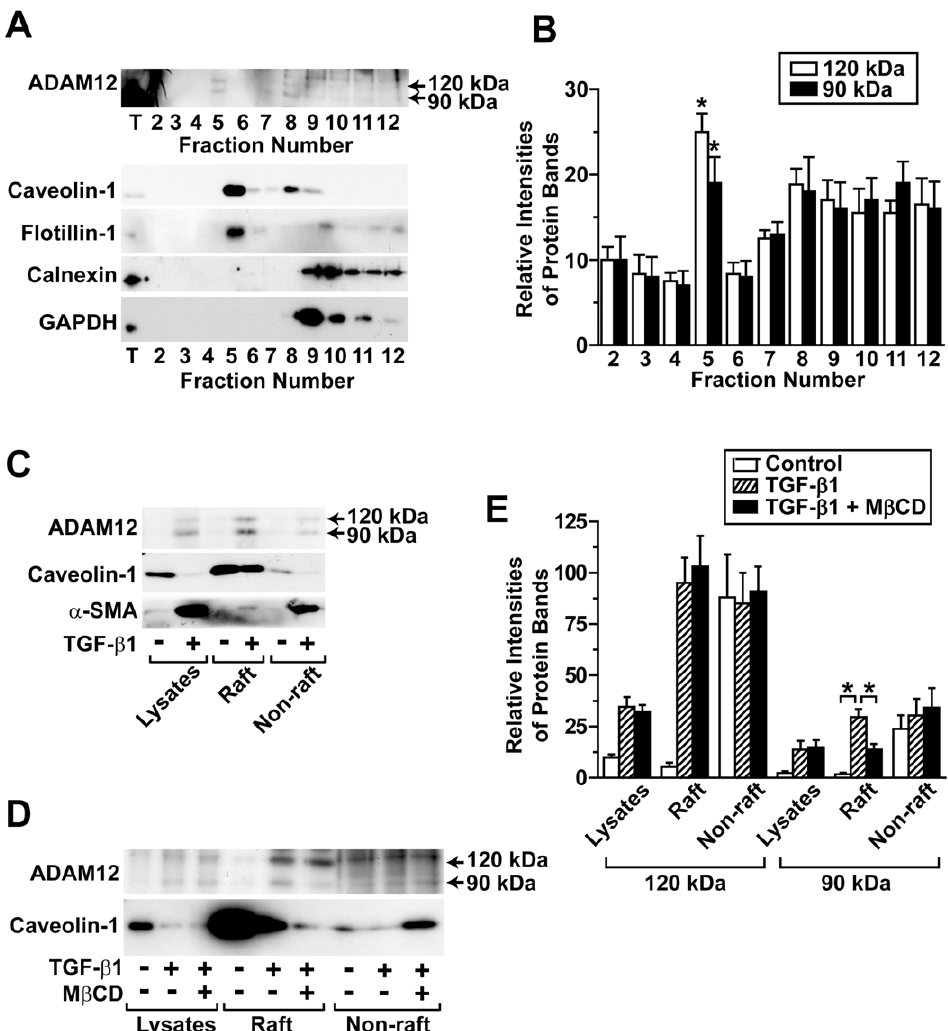
Figure 3. TGF- b 1-stimulated expression of ADAM12 in lipid raft fractions of hASCs. (A) Existence of ADAM12 in lipid raft fractions. hASCs were treated with 1 ng/mL TGF- b 1 for 4 days and lipid rafts were fractionated by sucrose density gradient centrifugation. The protein levels of ADAM12, caveolin-1, flotillin-1, calnexin, and GAPDH in each fraction were probed by Western blot analysis. (B) The relative intensities of ADAM12 protein bands with molecular masses of , 120 kDa and , 90 kDa from the panel (A) were quantified. * p , 0.05 vs fraction number 2. (C) TGF- b 1- stimulated expression of ADAM12 in lipid raft fractions. hASCs were treated with serum-free medium in the presence or absence of 1 ng/mL TGF- b 1 for 4 days, and then lipid rafts were fractionated. (D) Effects of cholesterol depletion on TGF- b 1-stimulated expression of ADAM12 proteins in lipid raft fractions. hASCs were treated with serum-free medium in the presence or absence of 1 ng/mL TGF- b 1 for 4 days. TGF- b 1-treated hASCs were subsequently treated with 5 mM M b CD or vehicles for 30 min. The expression levels of ADAM12, caveolin-1, and a -SMA in cell lysates, the lipid raft fraction ( # 5), and pooled non-lipid raft fractions (sample pooled from # 8–12) were determined by Western blotting. Representative data from three independent experiments are shown. (E) The relative intensities of ADAM12 protein bands with molecular masses of , 120 kDa and , 90 kDa from the panel (D) were quantified. * p , 0.05 by 2-way ANOVA followed by post hoc comparisons using Scheffe’s method.